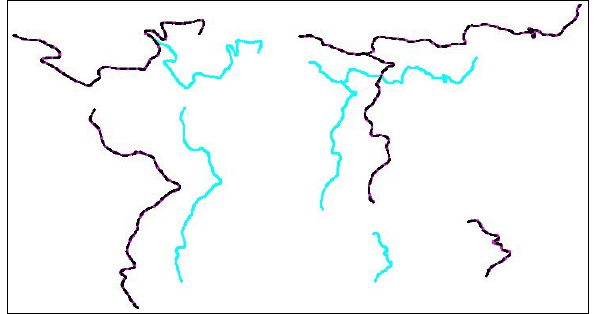
Figure 4. Test A: Matching results.